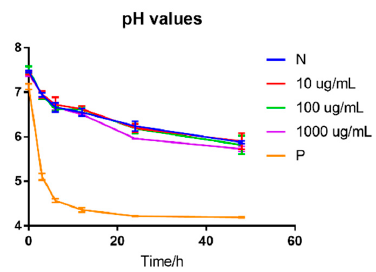
Figure 3. pH values of fermented samples of different concentrations of BLPs. N: blank, negative; P: positive control, samples supplemented with galacto-oligosaccharide.